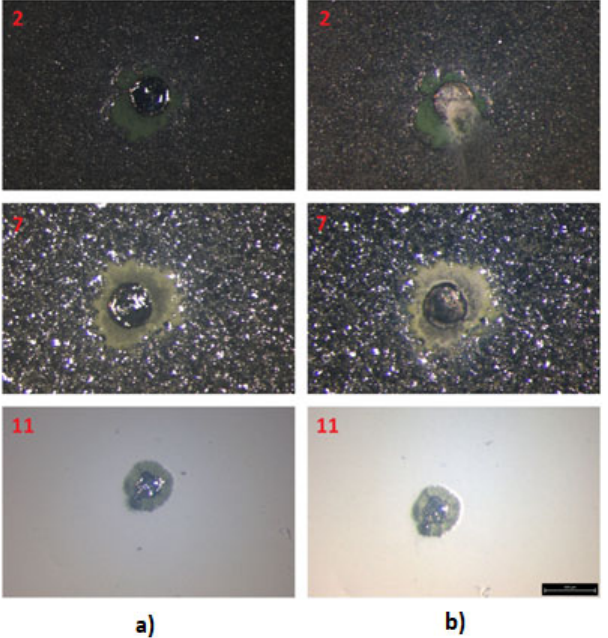
Figure 16. Comparison of samples before (left column a ) and after the salt chamber (right column b ).